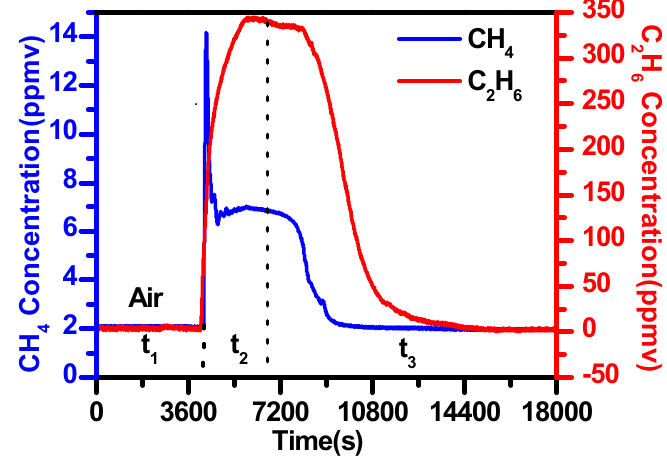
Figure 15. Simultaneous detection of methane and ethane “leakage”.